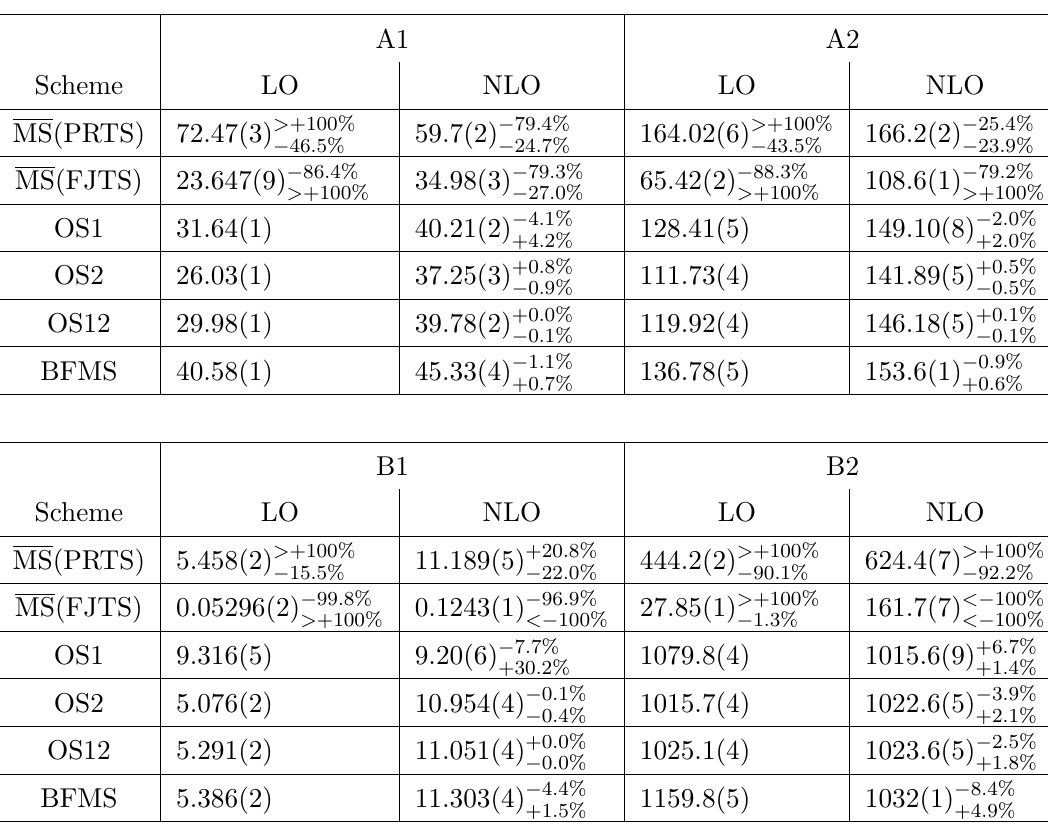
Table 12 . As in table 11, but for the cross section (cid:27) [fb] of heavy Higgs-boson production in Higgs-strahlung, pp H 1 (cid:22) + (cid:23) (cid:22) + X , in the !